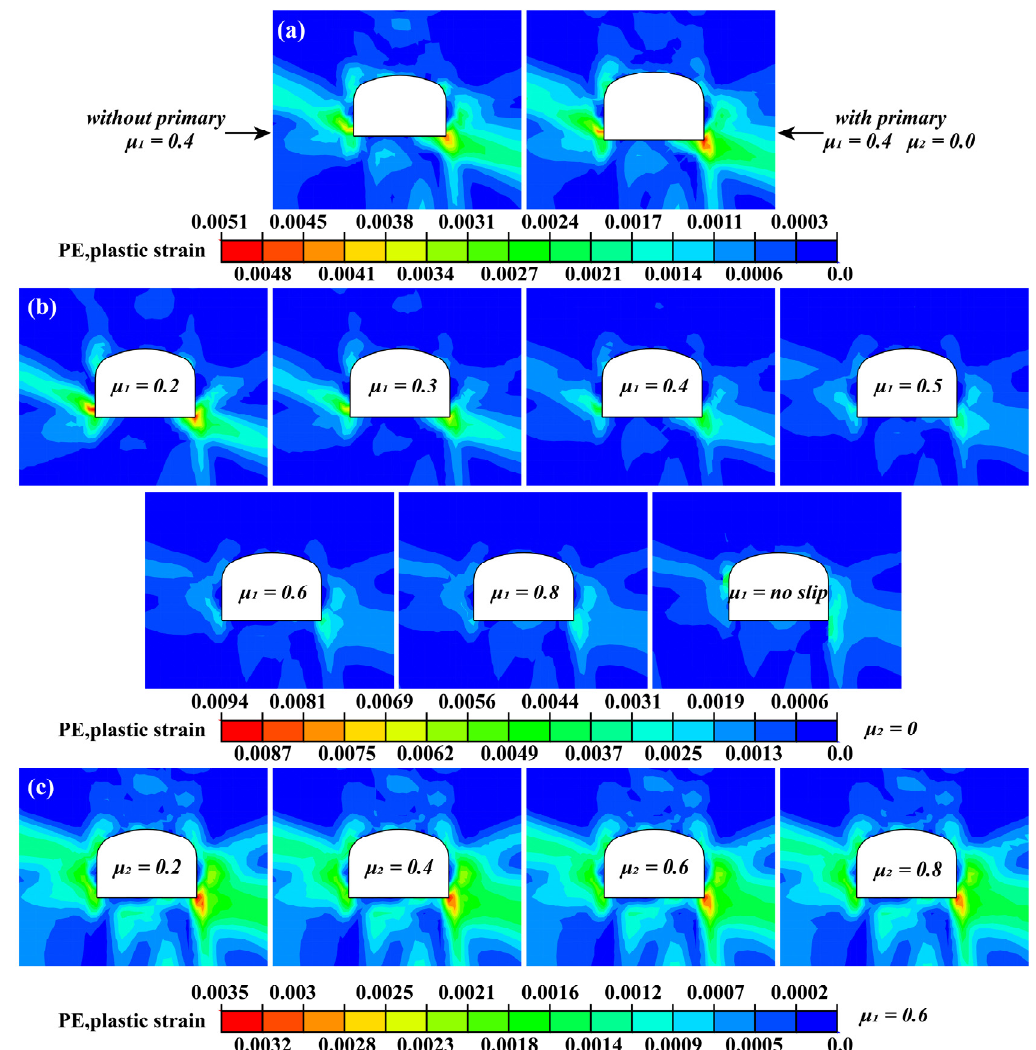
Figure 10. Soil plastic strain distributions ( a ) tunnels without and with primary lining ( b ) tunnels with primary lining; μ 1 = 0.2, 0.4, 0.6, 0.8 and no-slip; μ 2 = 0 ( c ) tunnels with primary lining; μ 1 = 0.6; μ 2 = 0.2, 0.4, 0.6, 0.8.